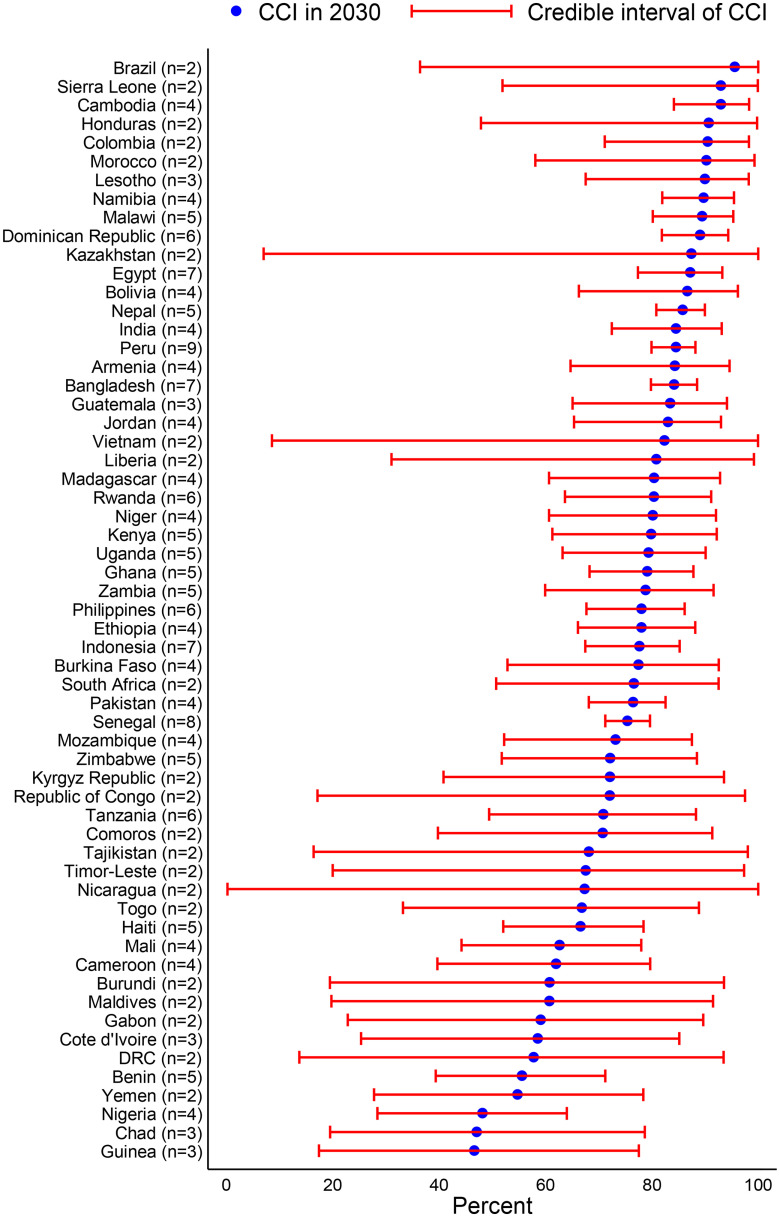
Projected Coverage in Percentages of Composite Coverage Index in 2030 Across CountriesaAbbreviation: CCI, composite coverage index.a Values in parentheses represent the number of surveys of the respective country that were used in the analysis.